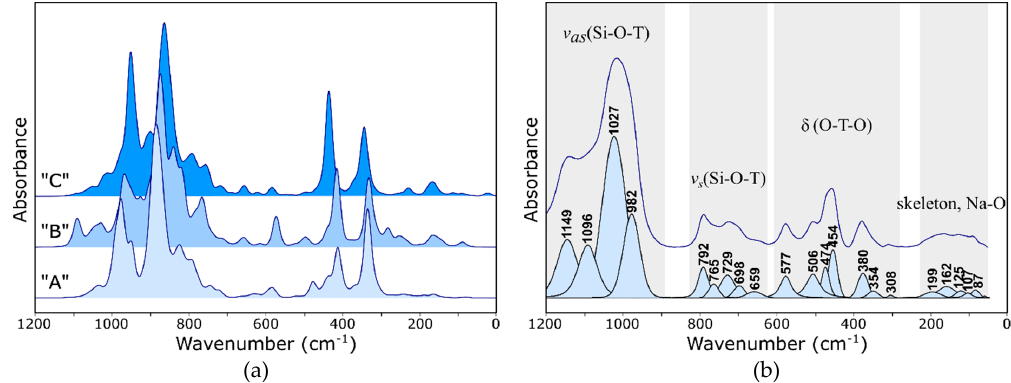
Figure 2. IR spectra of FAU: ( a ) calculated for the Na form of the “A”, “B” and “C” models ( b ) measured for the Na-Y zeolite.